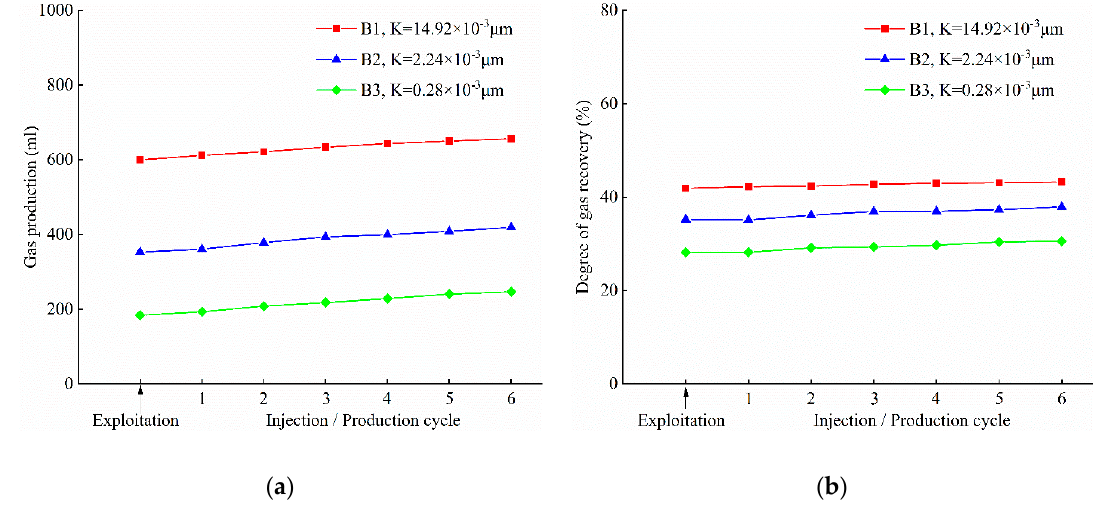
Figure 7. Variation curve of gas production ( a ) and degree of gas recovery ( b ) in the pre-UGS gas zone.